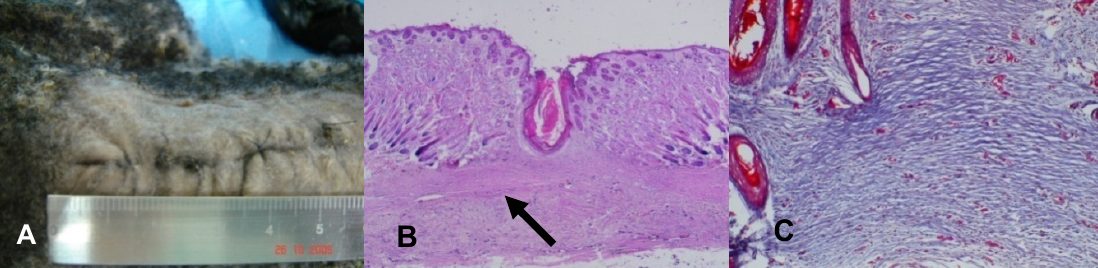
FIGURE 3 - (A) Macroscopic analysis of a skin scar at 140 days of gestation in the case group. (B) Microscopic analysis of hematoxilin/eosin stain-16X stained skin scar, showing an abundance of granular tissue and the patch used (arrow). (C) Trichrome stain-100X of a mature scar, showing dense collagen, with scattered vascular